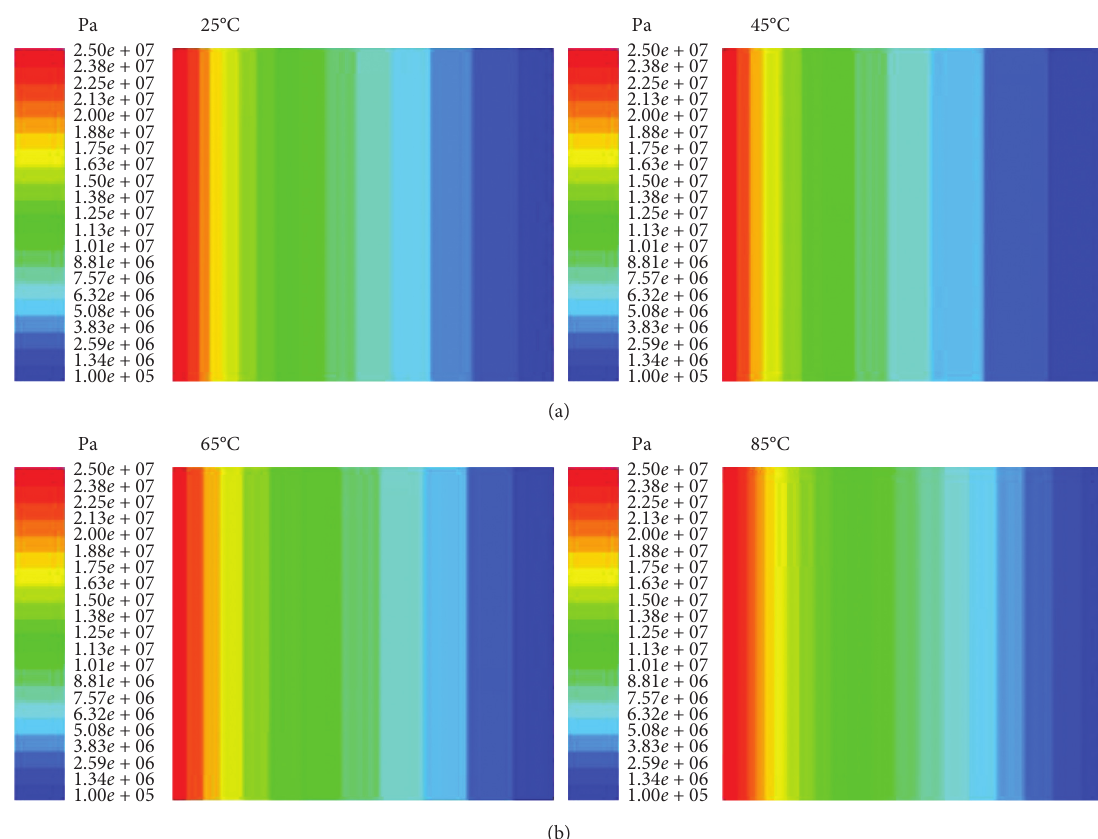
Figure 10: Vectors of pressure from inlet to outlet at 25 ° C–85 ° C.